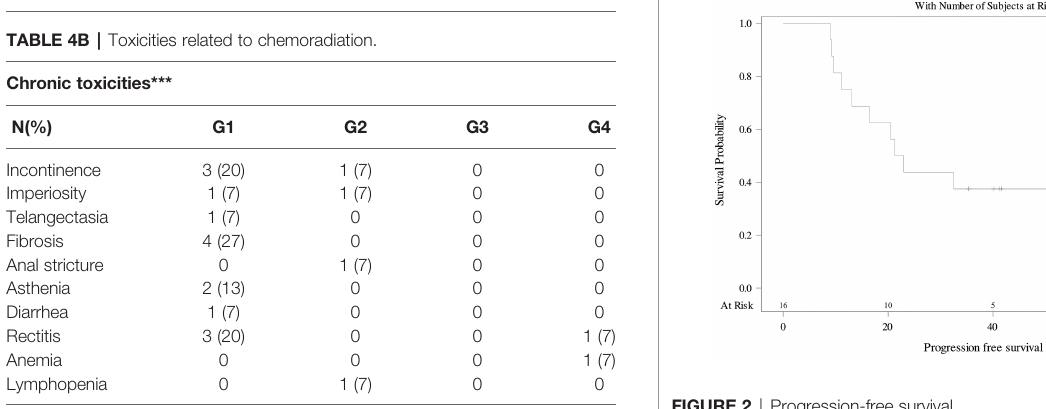
FIGURE 2 | Progression-free